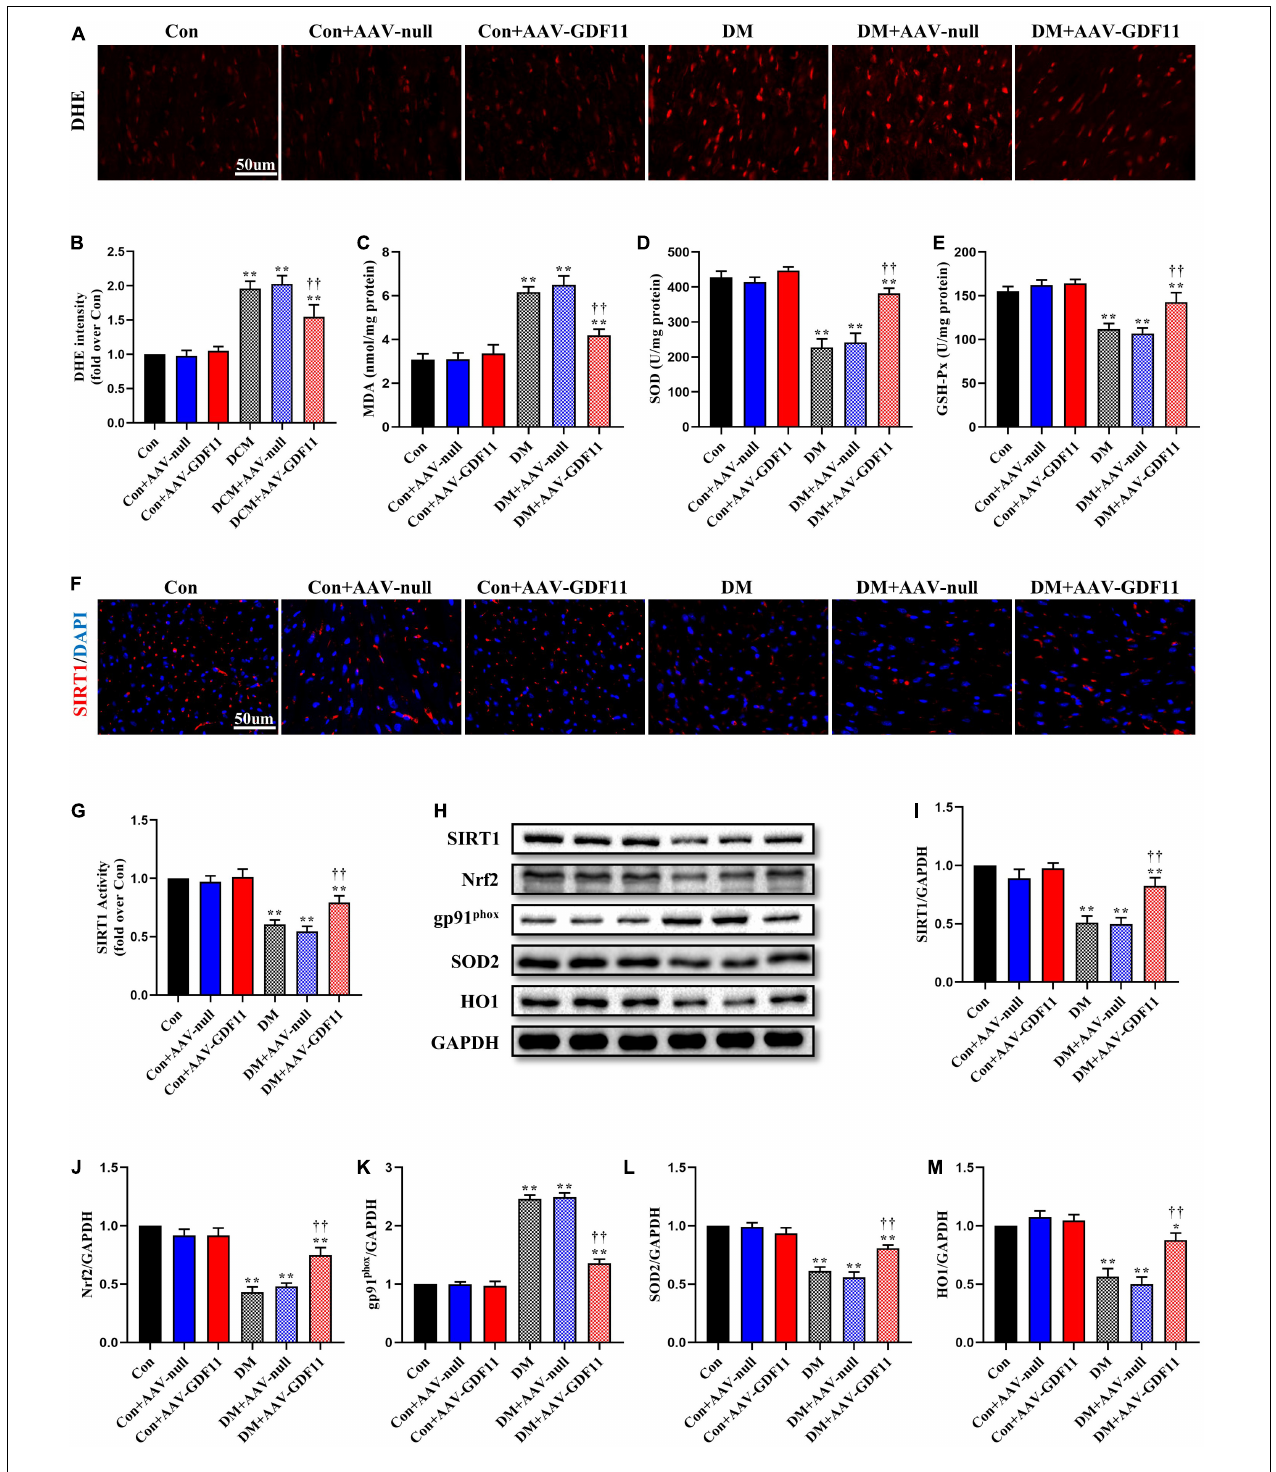
FIGURE 2 | GDF11 inhibited oxidative damage in diabetic cardiomyopathy (DCM) by upregulating SIRT1 expression. (A) Representative images of dihydroethidium (DHE) staining (scale bar = 50 µ m). (B) DHE fluorescence intensities. (C) Malondialdehyde (MDA) content. (D) Superoxide dismutase (SOD) activity. (E) Glutathione peroxidase (GSH-Px) activity. (F) Representative images of SIRT1 immunofluorescence in heart tissue. (G) The deacetylase activity of SIRT1. (H) Representative blots of SIRT1, Nrf2, gp91 phox , SOD2, and HO1. (I) Quantitative expression of SIRT1. (J) Quantitative expression of Nrf2. (K) Quantitative expression of gp91 phox . (L) Quantitative expression of SOD2. (M) Quantitative expression of HO1. Data are presented as the mean ± SEM, n = 5 or 6 per group. *,** P < 0.05, 0.01 versus the Con group, †† P < 0.01 versus the DM group.